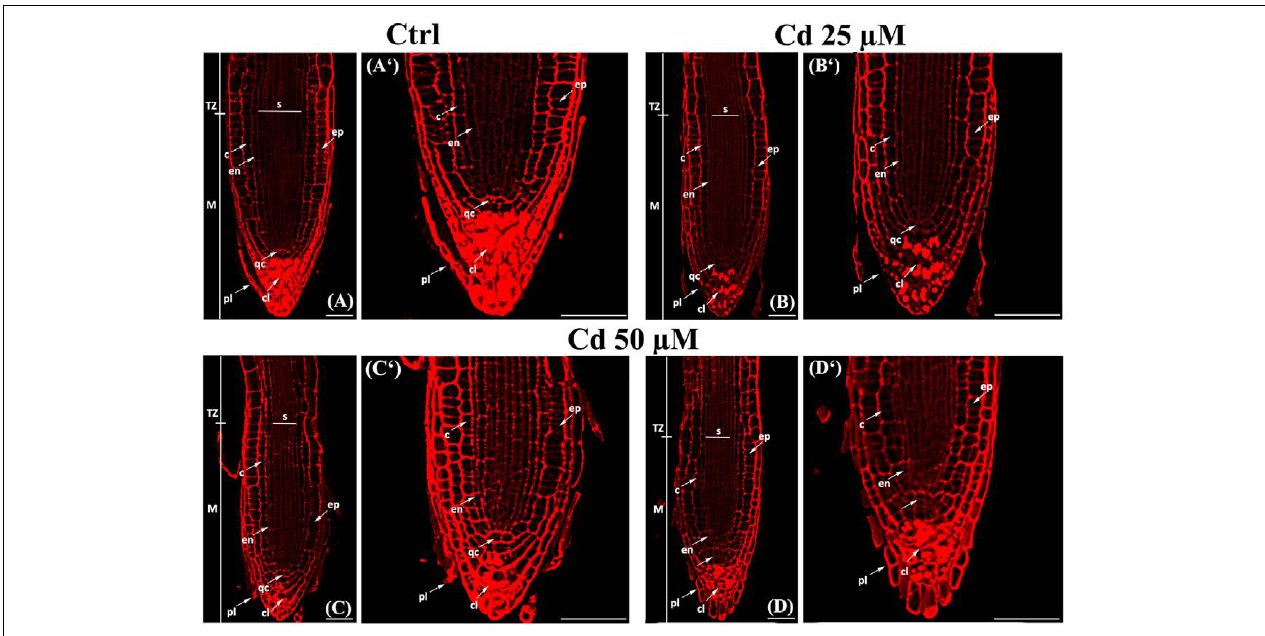
FIGURE 3 | Confocal laser images of primary root tip in A. thaliana seedlings germinated (A) on growth medium as control (Ctrl) and on medium added with (B) 25 and (C,D) 50 µ M Cd for 8 days after germination. (A ‘ –D ‘ ) Higher magnification of (A–D) , respectively. cl, columella; c, cortex; en, endodermis; ep, epidermis; M, meristematic zone; pl, cap peripheral layers; qc, quiescent center; s, stele; TZ, transition zone. Scale bars (A–D) 46 µ m; (A ‘ –D ‘ ) 53 µ